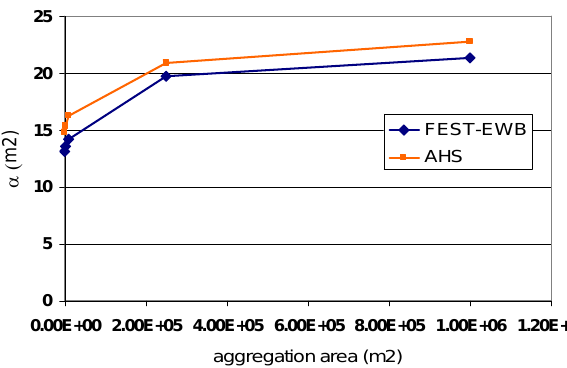
Fig. 11. Scales of fluctuation of LST for different aggregation areas.